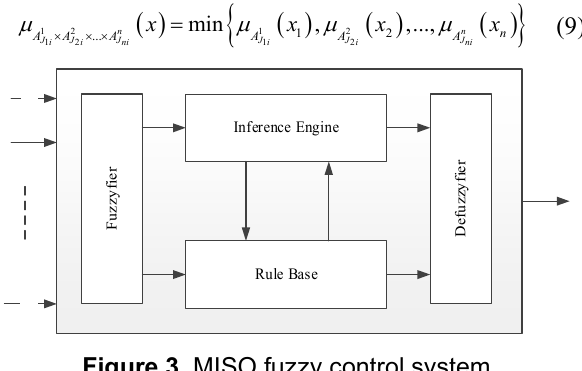
Figure 3. MISO fuzzy control